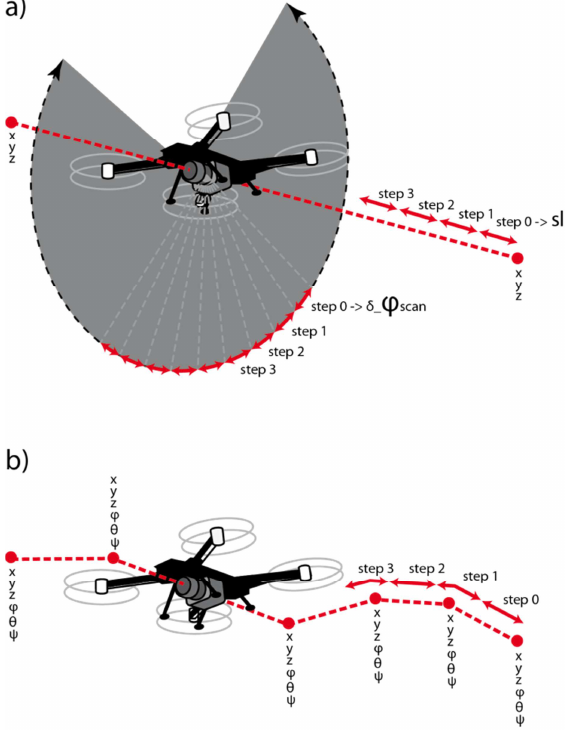
Figure 1. Principle of motion simulation for a) planned trajectory without orientation information per vertex and for b) flown trajectory with orientation information per